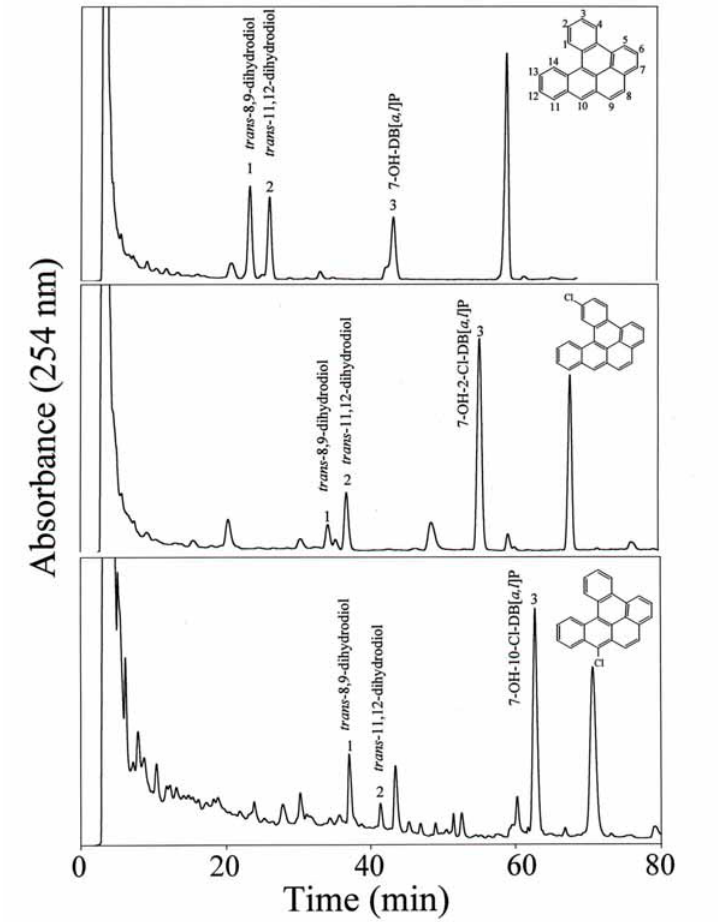
Figure 1. Reversed-phase HPLC profiles of the organic solvent extractable metabolites obtained from incubation of (A) DB[ a,l ]P, (B) 2-Cl-DB[ a,l ]P and (C) 10-Cl-DB[ a,l ]P with liver microsomes from rats pretreated with